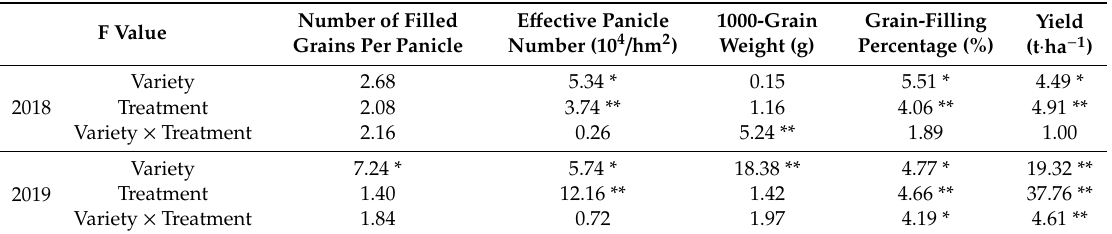
Table 3. Interaction of varieties and treatments on yield and its components in giant